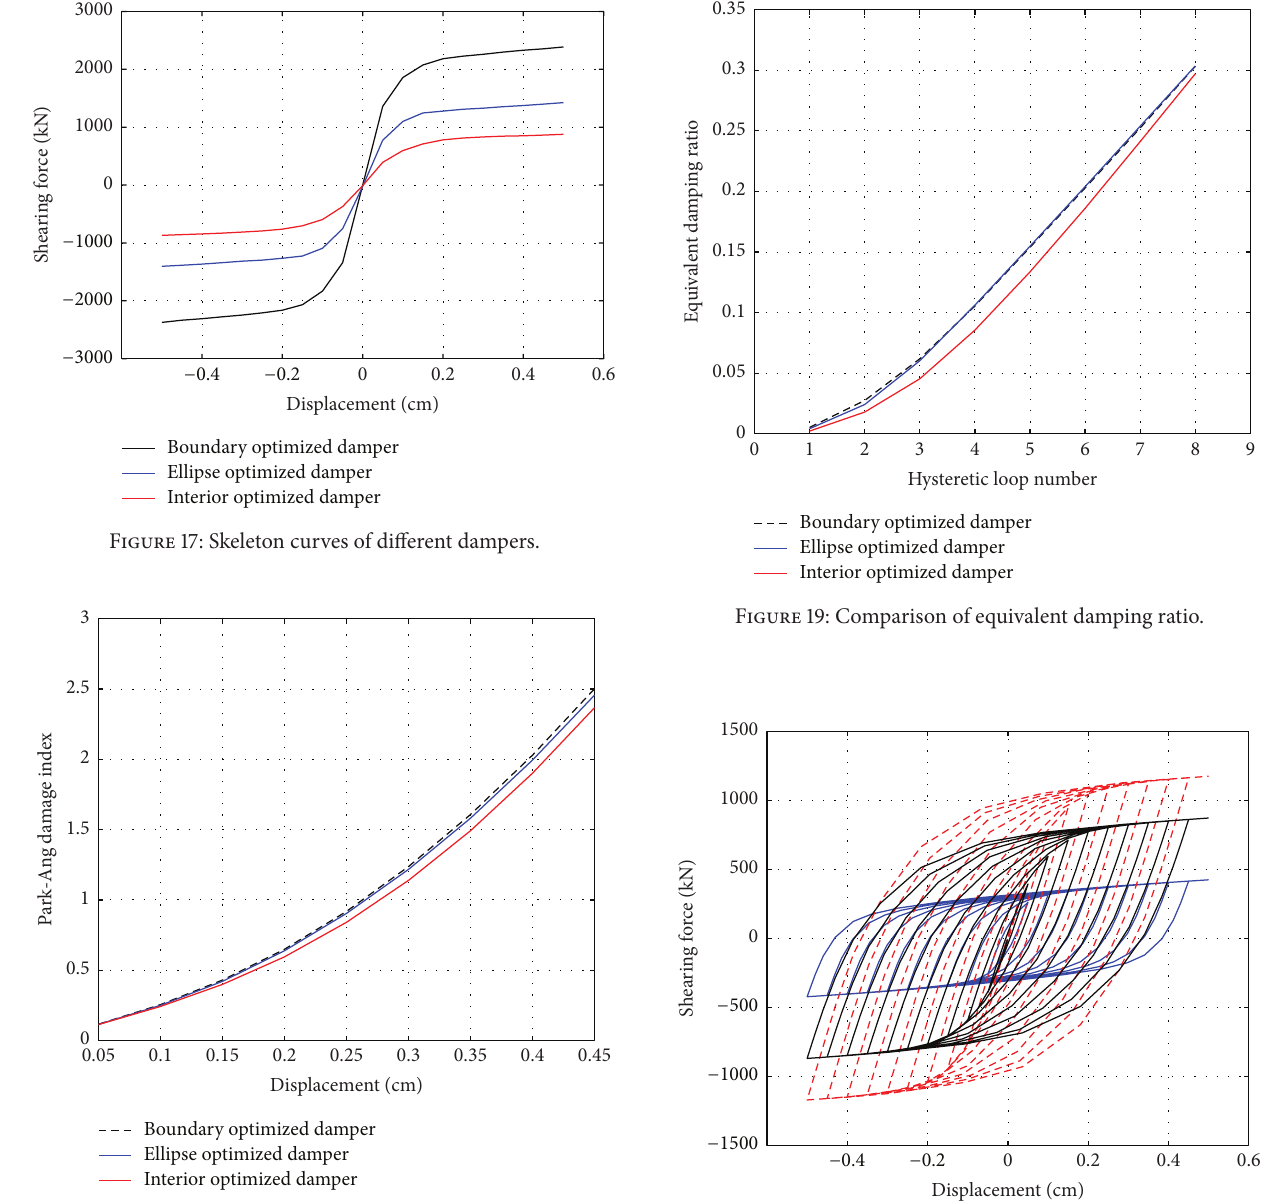
Figure 18: Comparison of damage index.